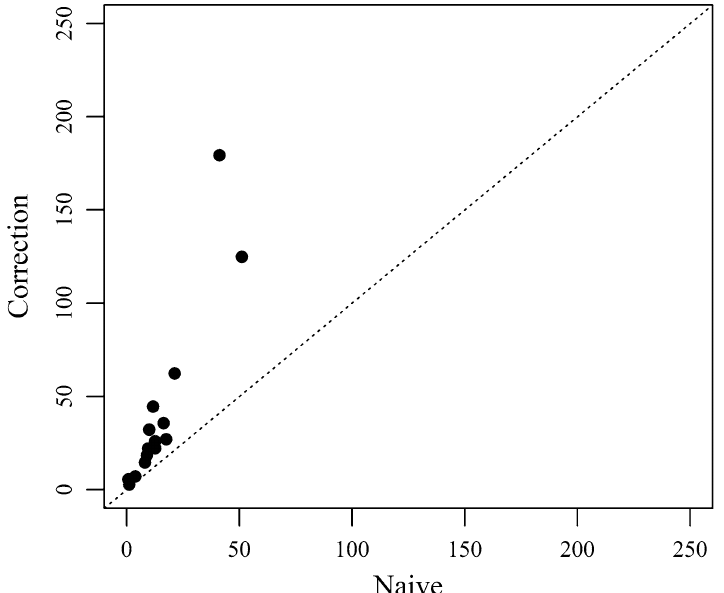
Fig. 3 Mathematics naive and correction model parameters for the SES Index. Note. Parameter estimates are the posterior